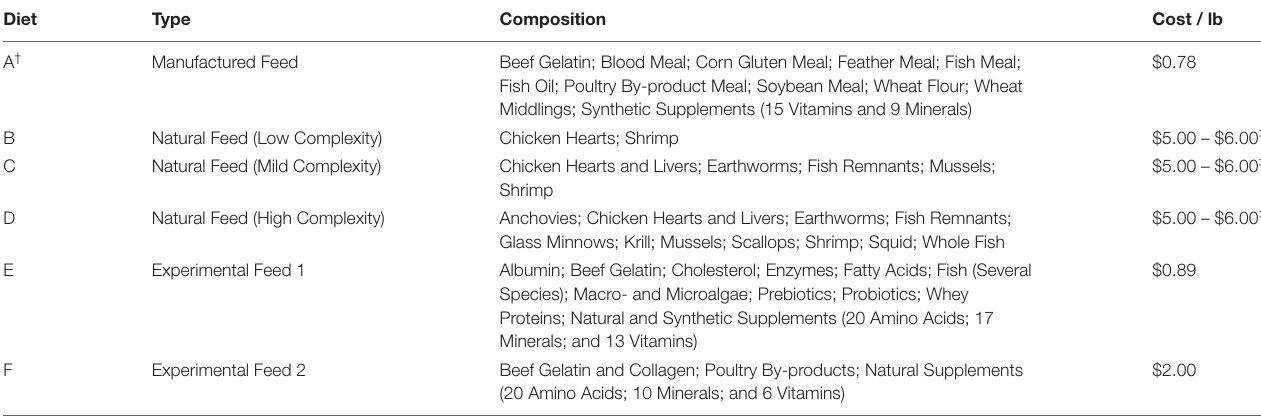
TABLE 2 | Composition and costs of feed trial diets.